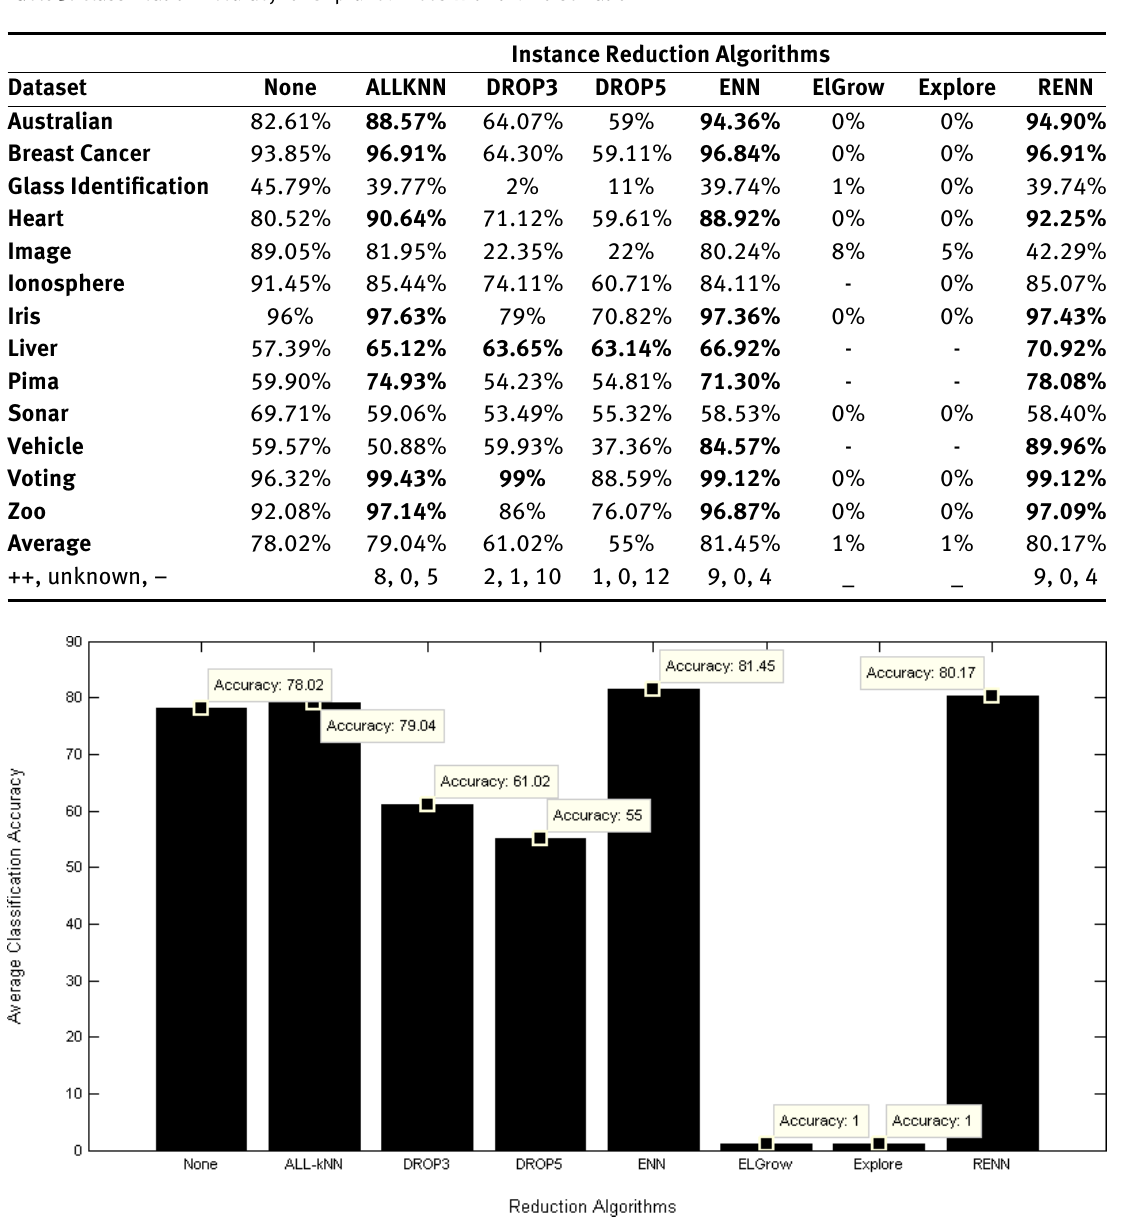
Table 3: Classification Accuracy for Unpruned Trees With 0% Noise Ratio